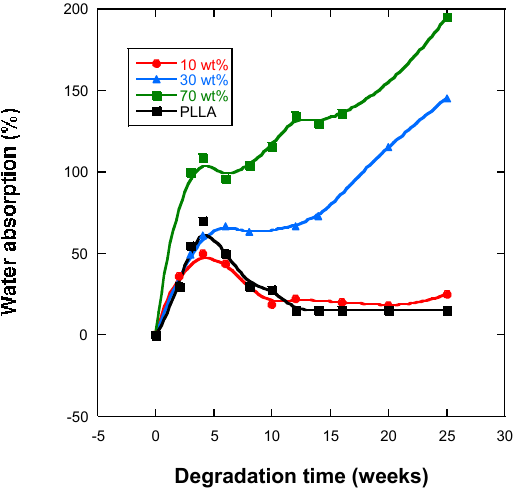
Figure 4. Water absorption by PLLA, PLLA-10%Fe 3 O 4 , PLLA-30%Fe 3 O 4 , PLLA-70%Fe 3 O 4 .